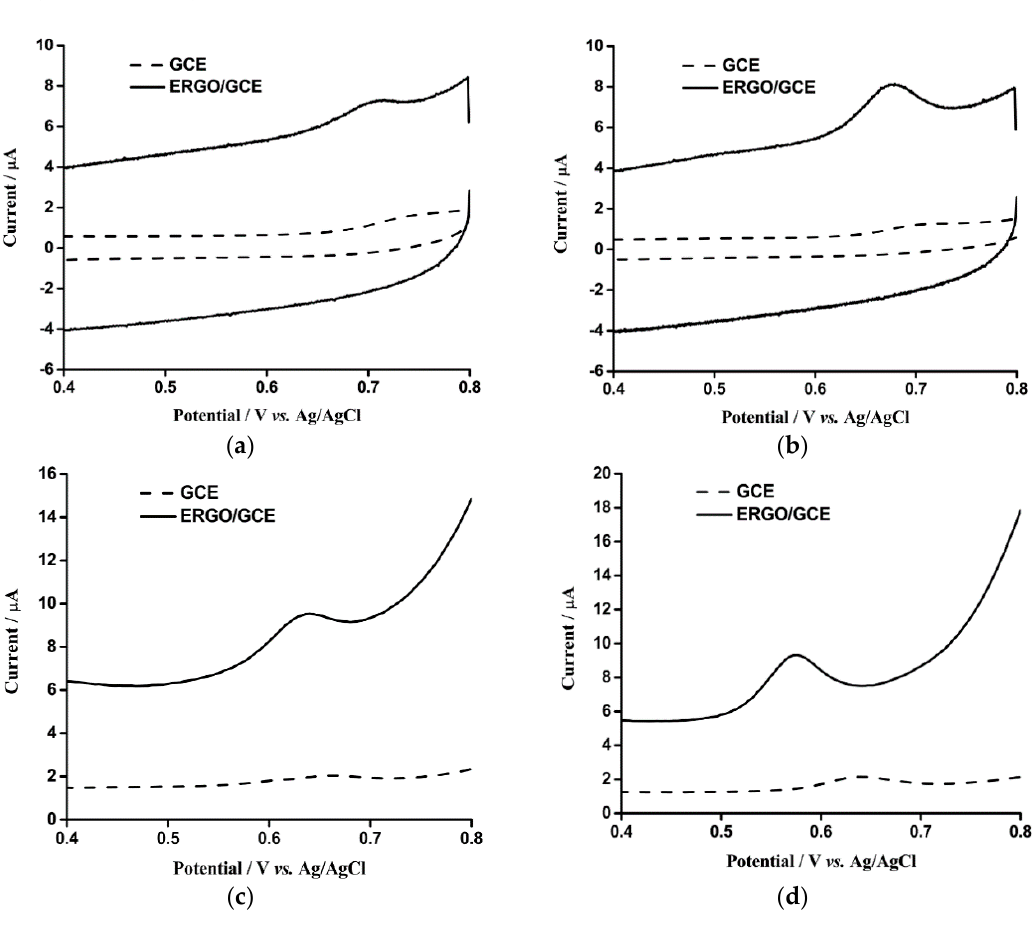
Figure 3. ( a , b ): CV of GCE (dash line) and ERGO/GCE (solid line) in 0.1 M phosphate buffer solution (pH 7.0) containing 5 μ M (OA) ( a ) and 5 μ M (TA) ( b ). The potential range: 0.4 to 0.8 V; scan rate: 100 mV·s − 1 . ( c,d ): DPV of GCE (dash line) and ERGO/GCE (solid line) in 0.1 M phosphate buffer solution (pH 7.0) containing 5 μ M (OA) ( c ) and 5 μ M (TA) ( d ). The potential range: 0.4 to 0.8 V; amplitude: 80 mV (OA) and 100 mV (TA); pulse width: 40 ms (OA) and 50 ms (TA); pulse repetition time: 0.1 s (OA) and 0.3 s (TA); the ERGO/GCE was modified by scanning 12 CV cycles.